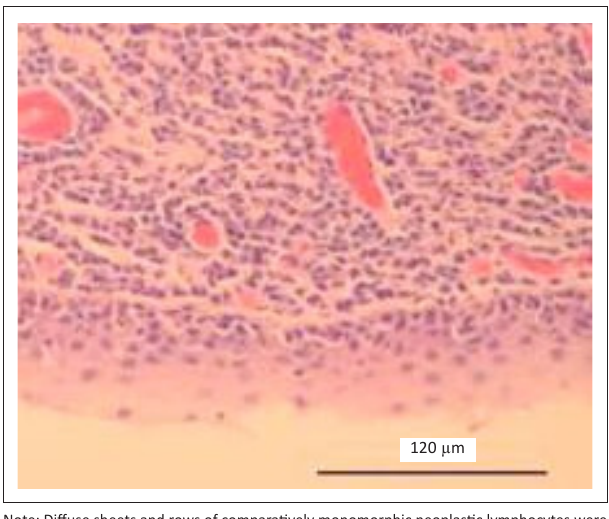
FIGURE 6: Clitoris: Canine, diffuse small cell lymphoma (Tissue